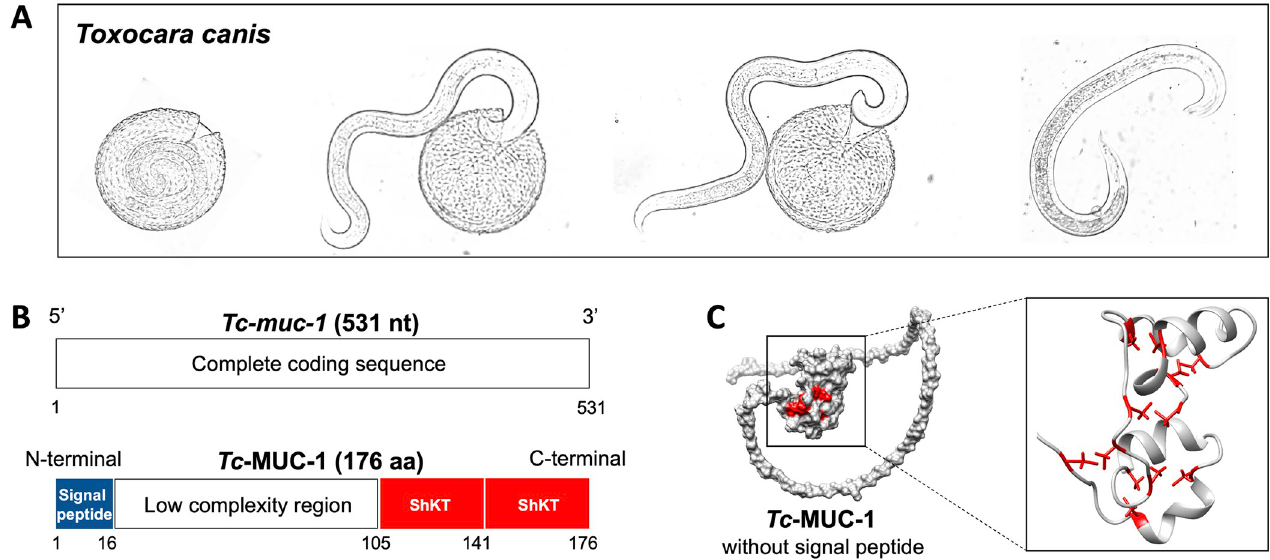
Fig 1. Molecular cloning and functional prediction of Toxocara canis mucin 1 ( Tc -MUC-1). ( A ) Infective larvae of T . canis hatch from eggs in vitro are used for the molecular cloning of the gene ( Tc-muc-1 ) encoding the Tc -MUC-1 protein. ( B ) Schematic diagram of Tc-muc-1 and the predicted domain architecture of Tc -MUC-1. Signal peptide, low complexity region and two abutting ShKT domains are indicated. ( C ) The three-dimensional structure of Tc -MUC-1 (without signal peptide) modelled using AlphaFold2 [38]. Cysteine residues and disulfide bonds in each ShKT domain are indicated in red.